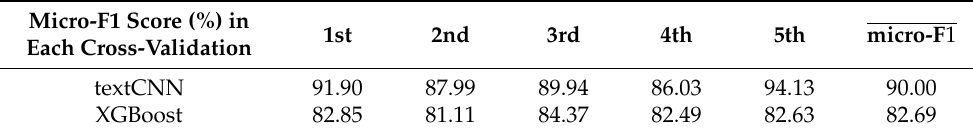
Table 4. Classifier performance of textCNN and XGBoost.